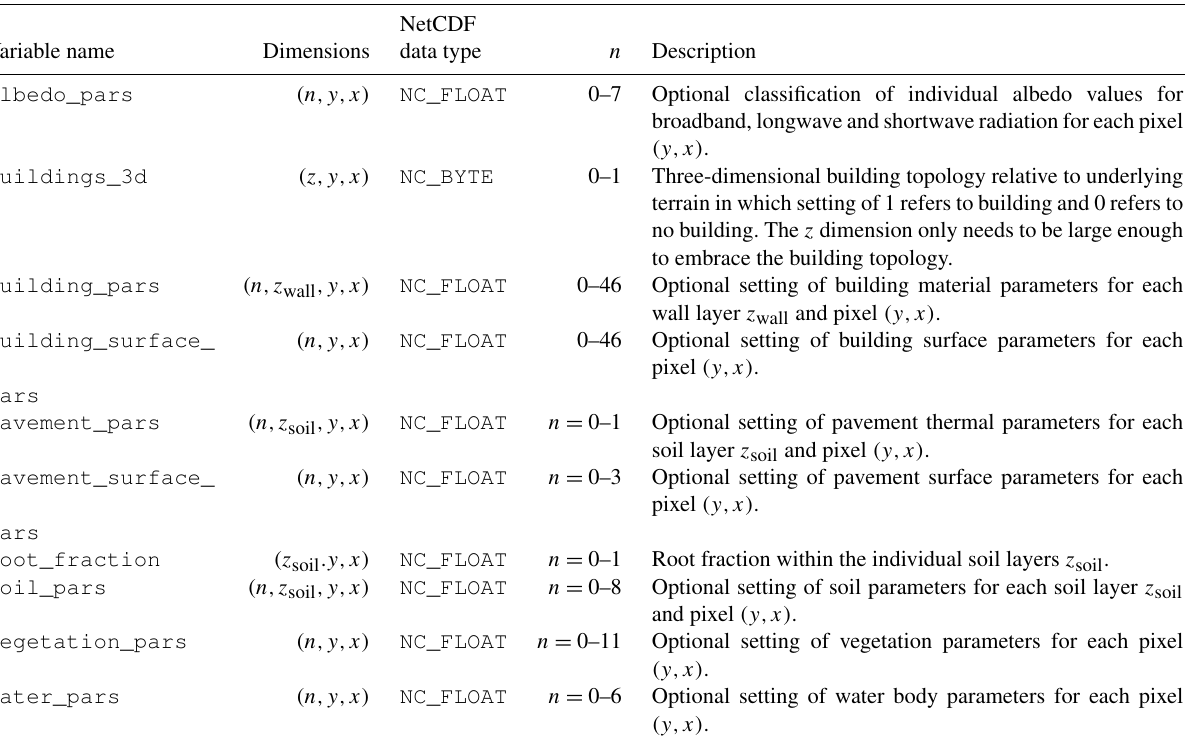
Table 2. List of LOD2 variables that can be specified in the static driver